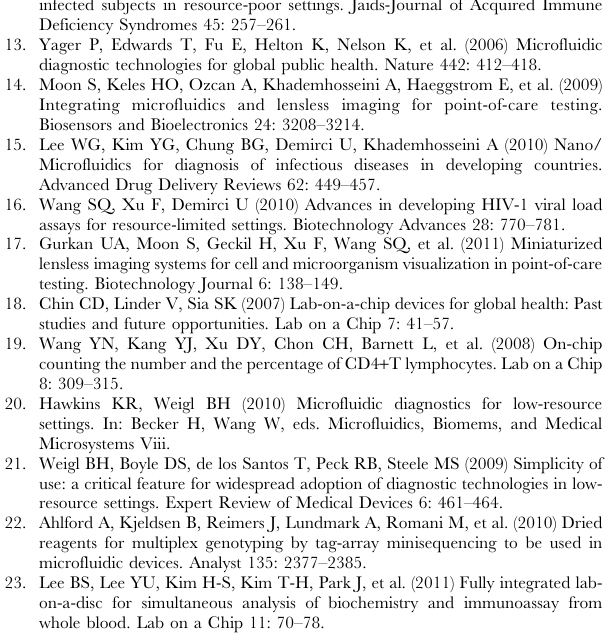
Table S1 Standard Operation Procedure (SOP) for fabricating the microfluidic chips prior to applying the surface chemistry.